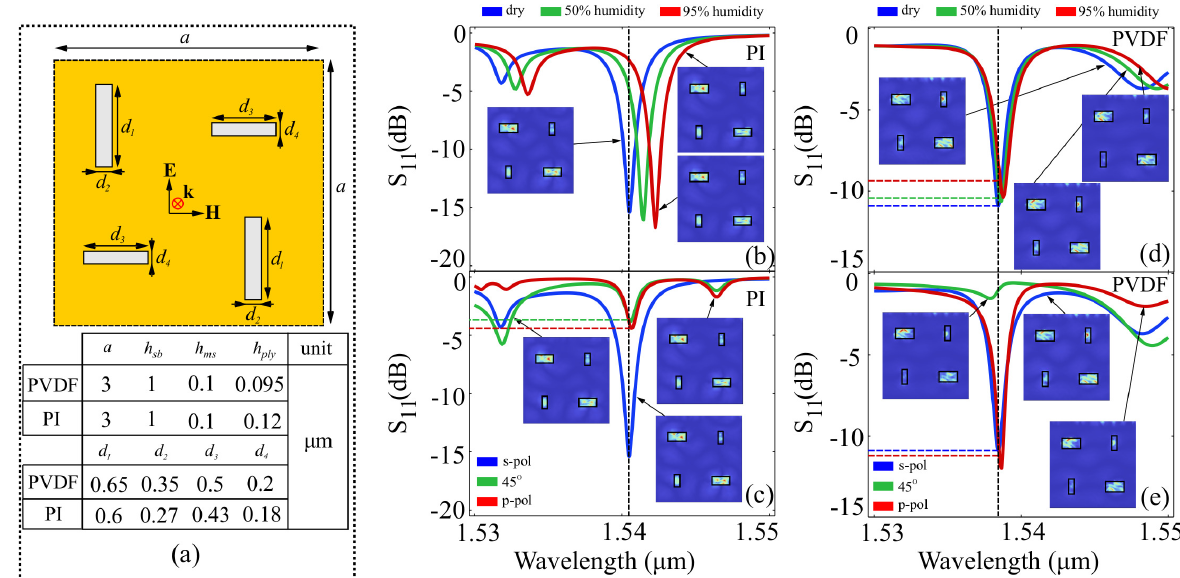
Figure 3. Results obtained for the rod-based structure. ( a ) Layout of the ring elements and element sizes chosen for the PVDF and PI in order to have a resonant response around the working wavelength; ( b ) spectral behavior of the PI rod-element structure at different humidity levels and ( c ) at different input polarization states; and ( d ) spectral behavior of the PVDF rod-element structure at different humidity levels and ( e ) at different input polarization states. For subfigures ( b – e ), the insets show the local field enhancement in the interface plane taken at the resonance